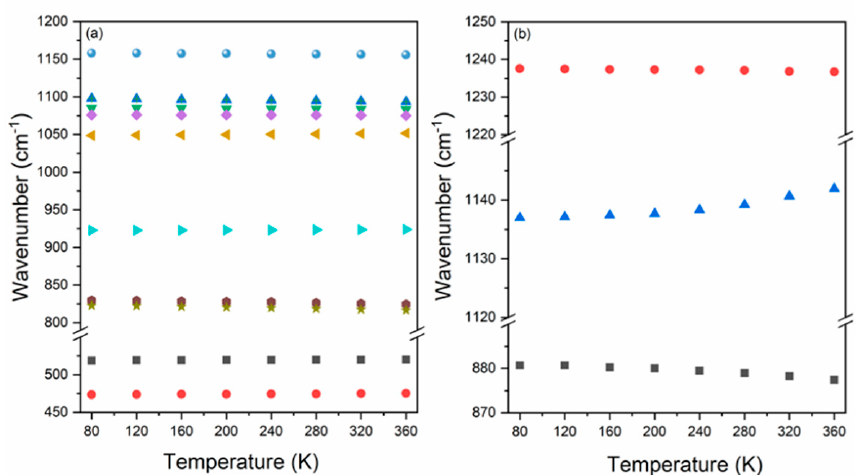
Figure 4. The temperature evolution of Raman wavenumbers of bands corresponding to vibrations of groups that built up ( a ) H 2 PO 2 − and ( b ) MHy + ions.